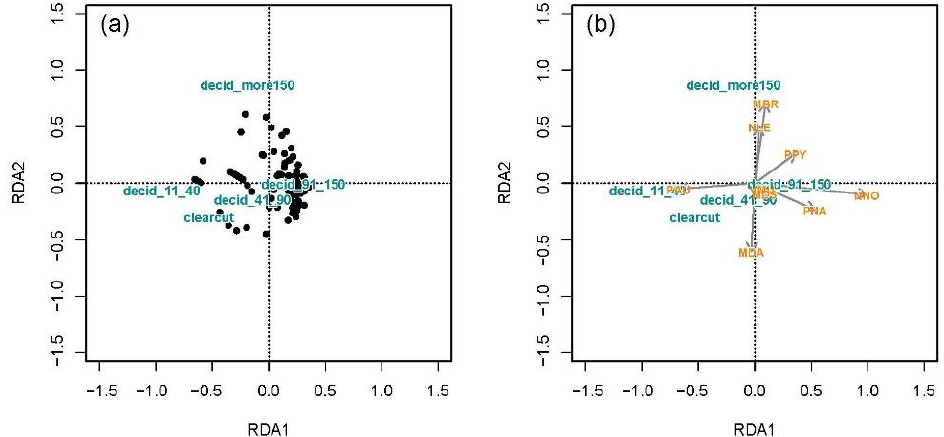
Figure 5. Results of redundancy analysis revealing the relationship between the forest age and assemblage structure at the site level. ( a ) Overlay of samples (at each site) and forest age classes shown in green–blue: clearcut, decid_11_40, decid_41_90, decid_91_150 and decid_more150. ( b ) Overlay of species shown with grey arrows and orange 3-letter species abbreviations and forest age classes shown in green – blue.